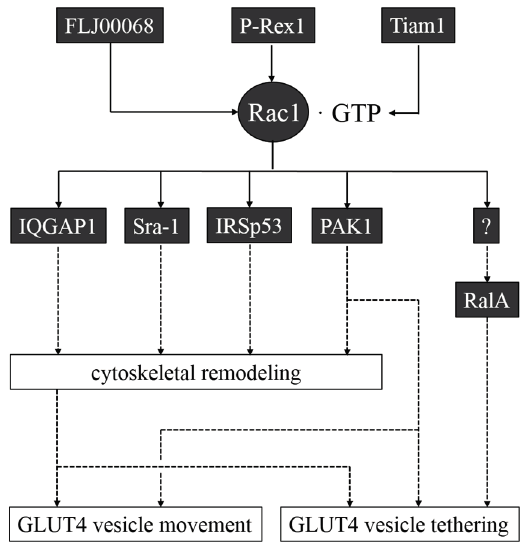
Figure 3. GEFs and target proteins of Rac1 that may be implicated in GLUT4 translocation to the plasma membrane in skeletal muscle and adipocytes. FLJ00068 and P-Rex1 are GEFs that regulate Rac1 activity in skeletal muscle and adipocytes, respectively. Another Rac1 GEF, Tiam1, may also be involved in Rac1 activation. The scaffold protein IQGAP1, the cytoplasmic protein Sra-1, the adaptor protein IRSp53, and the protein kinase PAK1 are Rac1 targets that regulate cytoskeletal remodeling in various tissues. PAK1 may have other roles in GLUT4 translocation. The Ras family small GTPase RalA has been implicated in the regulation of GLUT4 vesicle tethering downstream of Rac1, but a Rac1 target that links Rac1 to RalA remains